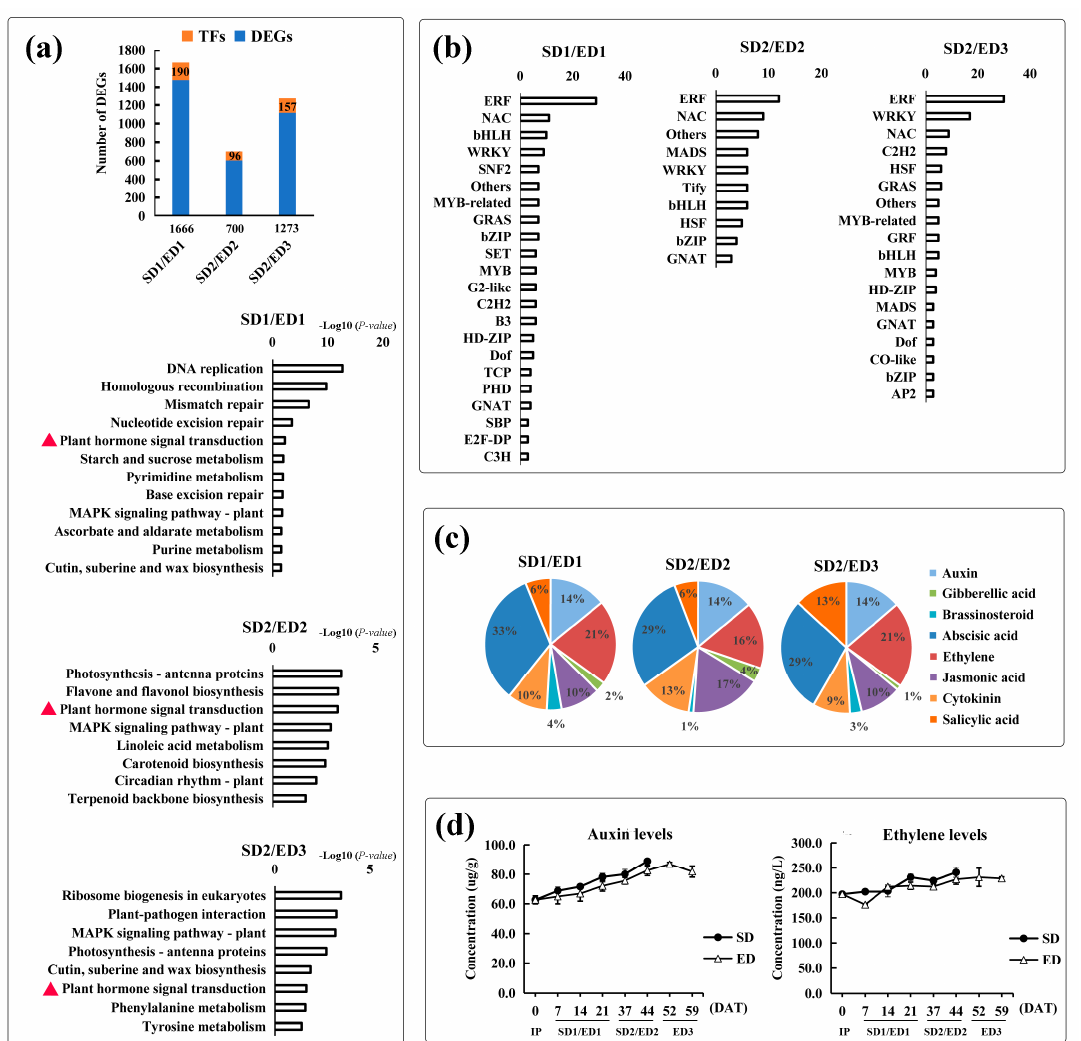
Figure 3. The overall analyses of DEGs in the three comparisons between SD and ED light cycles. ( a ) KEGG enrichment analysis of DEGs. All terms were listed ( p -value < 0.05). ( b ) The detailed information of transcription factors (TFs) in the DEGs. ( c ) The pie charts represent the percentage of DEGs (including up- and down-regulated DEGs) involved in phytohormone signal transduction entry. ( d ) The concentration of auxin and ethylene according to the sampling time of RNA-Seq.